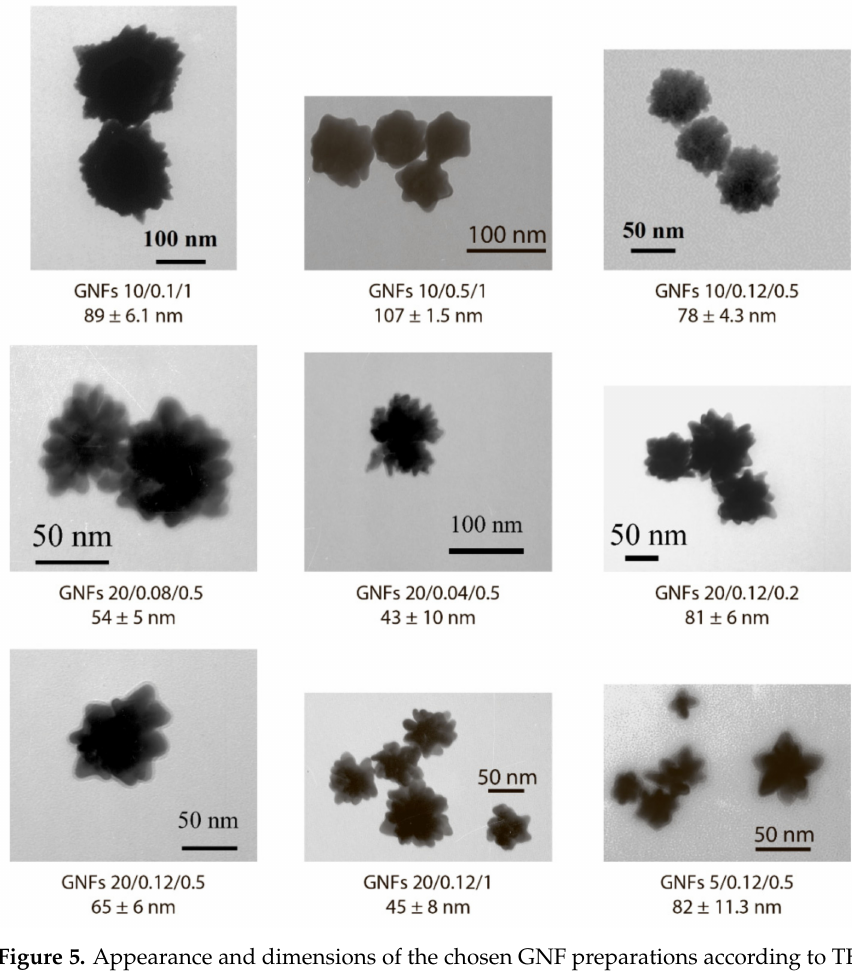
Figure 5. Appearance and dimensions of the chosen GNF preparations according to TEM data.